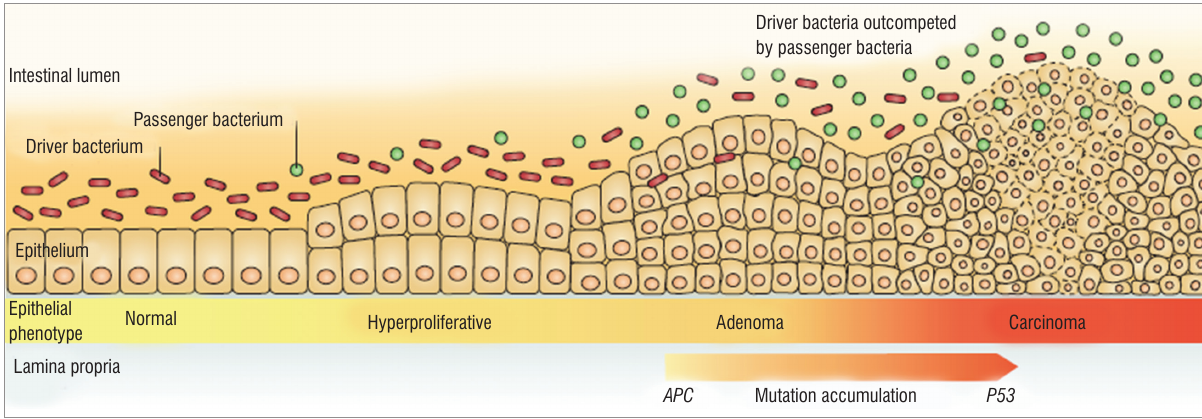
A bacterial driver–passenger model for colorectal cancer (CRC). The colonic mucosa of patients who are at risk of CRC is intrinsically colonised by pathogenic members of the genus Bacteroides (Enterobacteriaceae) or by bacteria that function as ‘drivers’ of CRC that cause inflammation, increased cell proliferation and/or the production of genotoxic substances that contribute to the accumulation of mutations during the adenoma-carcinoma sequence. The oncogenic process is accompanied by the rupture and bleeding of the cancerous tissue that alters the micro-environment and the selective pressure on local microbiota. These changes facilitate the gradual replacement of ‘driver’ bacteria by ‘passengers’, consisting of tumour-foraging opportunistic pathogens, commensal or probiotic bacteria, or other bacteria with a competitive advantage at the tumour. Tumour progression may be either suppressed (by probiotic ‘passenger’ bacteria) or promoted (by pathogenic ‘passenger’ bacteria) as a result of these microbial colonisation